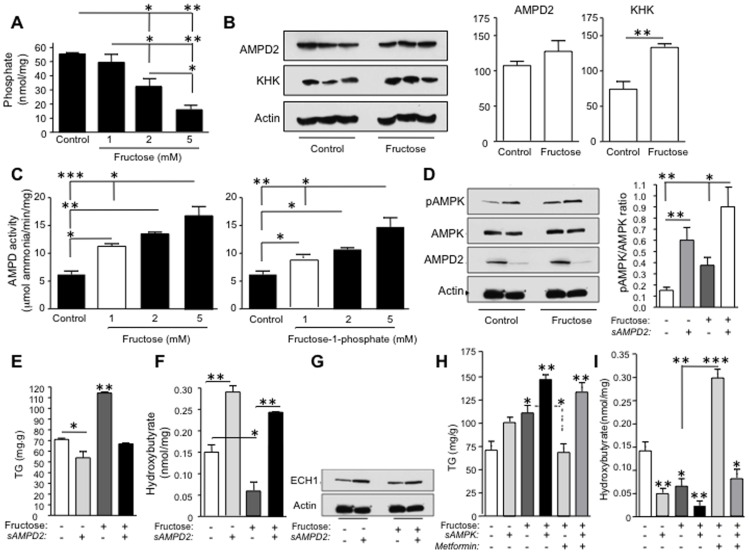
Fructose stimulates fat accumulation in HepG2 cells by activating AMPD2 and blocking AMPK and fat oxidation.A) Fructose reduces intracellular phosphate levels –a natural inhibitor of AMPD activity- in a dose-dependent manner. *p<0.05, **p<0.01. B) AMPD2 expression is not modified by fructose in human hepatocytes. As control, fructokinase (KHK) expression is significantly up-regulated. **p<0.01. C) Both fructose (1–5 mM) and fructose-1-phosphate (1–5 mM) -the product of fructokinase metabolism- significantly up-regulates the activity of AMPD2 in human hepatocytes. AMPD activity was measured after 30 minutes exposure to fructose in 50 µg protein lysates *p<0.05, **p<0.01. D) Fructose stimulates AMPK activity (as determined by phosphorylation at Thr172) that is further amplified in AMPD2 silenced cells. *p<0.05, **p<0.01. E) Fructose induces triglyceride accumulation in HepG2 cells that is blocked in AMPD2 deficient cells *p<0.05, **p<0.01 F) Fructose decreases β- hydroxybutyrate levels in HepG2 cells that are blocked in AMPD2 deficient cells *p<0.05, **p<0.01. G) ECH1 expression is up-regulated in AMPD2 deficient cells exposed to fructose. H) Silencing AMPK expression increases triglyceride accumulation in non-exposed and fructose exposed HepG2 cells that is not blocked with 10 µM metformin *p<0.05, **p<0.01 I) Silencing AMPK expression decreases intracellular β- hydroxybutyrate levels in non-exposed and fructose exposed HepG2 cells that is not blocked with 10 µM metformin *p<0.05, **p<0.01, ***p<0.001.